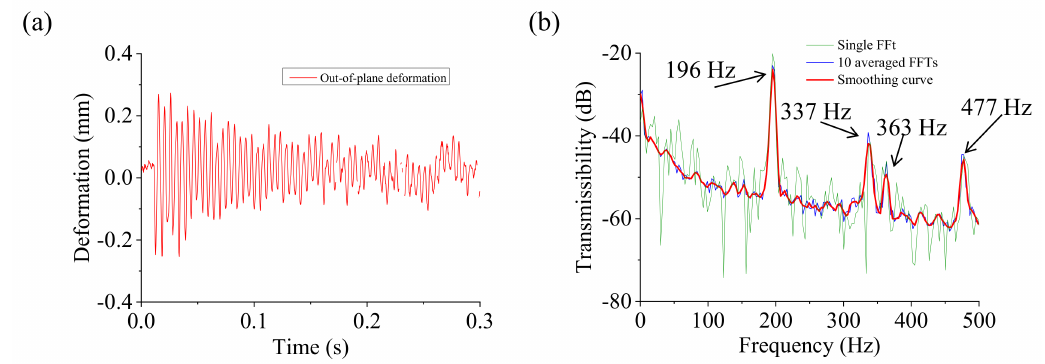
Figure 17. Dynamic characteristics of the skeleton TPS panel (TPS panel without fibrous insulation material): ( a ) deformation response of a point on the front plate of the TPS panel, ( b ) spectral data of the deformation